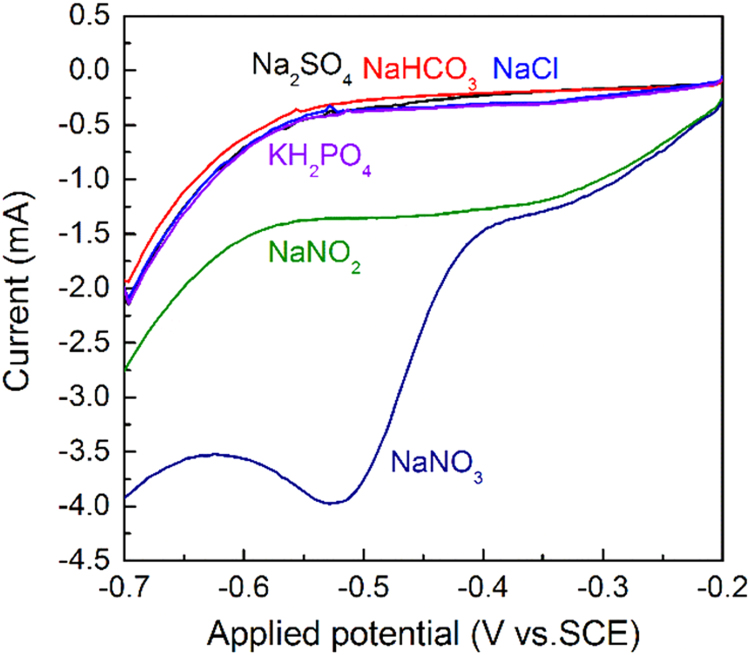
LSV curves of Cu-NWs electrode in 0.1 M Na2SO4 electrolyte (pH = 2) with sequential addition of 1 mM NaHCO3, 1 mM NaCl, 1 mM KH2PO4, 1 mM NaNO2, and 1 mM NaNO3.